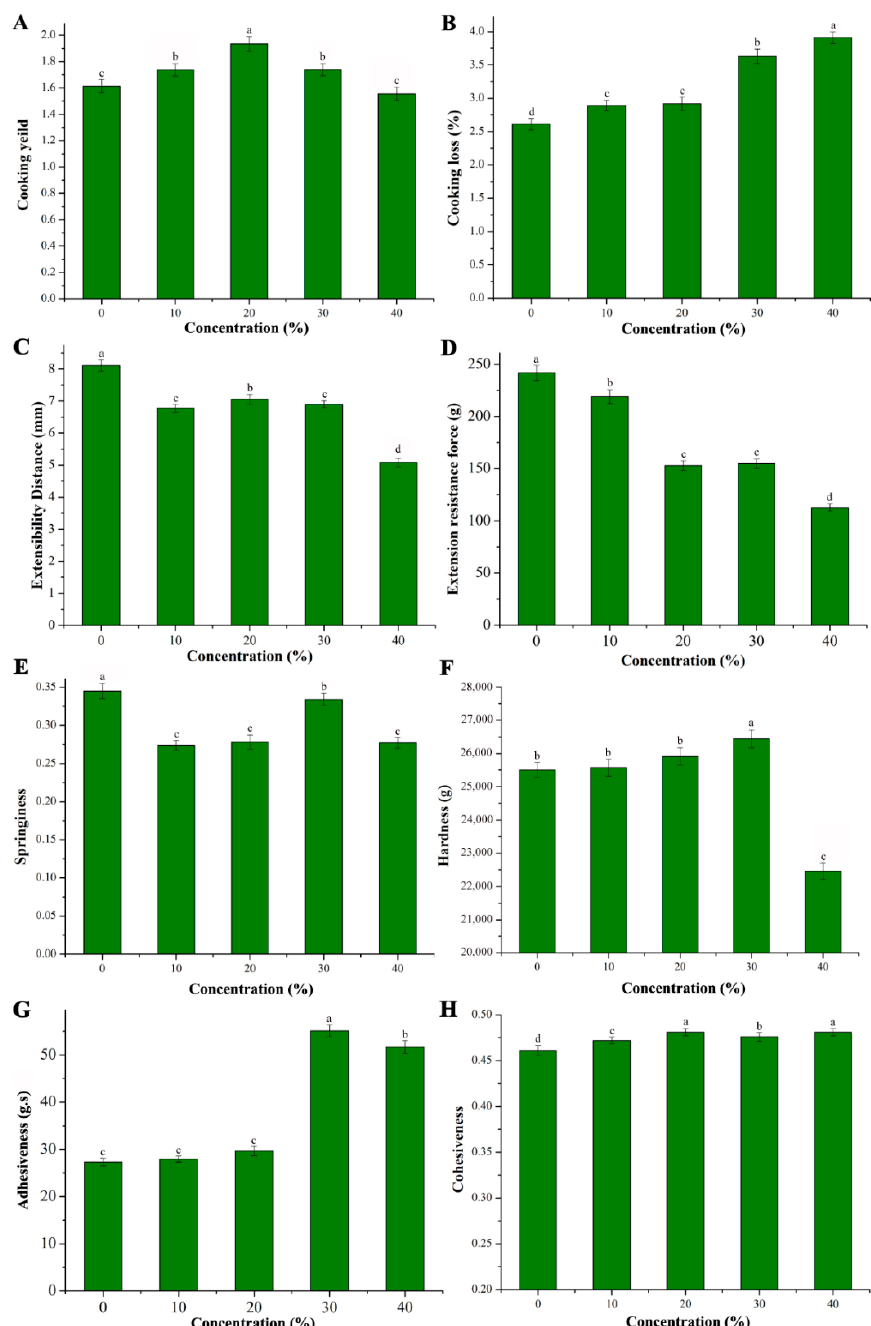
Figure 2. E ff ects of wheat flour supplemented with di ff erent levels of Chinese yam powder on cooking properties, tension properties, and texture properties. Cooking yield ( A ), Cooking loss ( B ), Extensibility distance ( C ), Extensibility resistance force ( D ), Springiness ( E ), Hardness ( F ), Adhesiveness ( G ), Cohesiveness ( H ). The values followed by di ff erent letters were significantly di ff erent ( p <